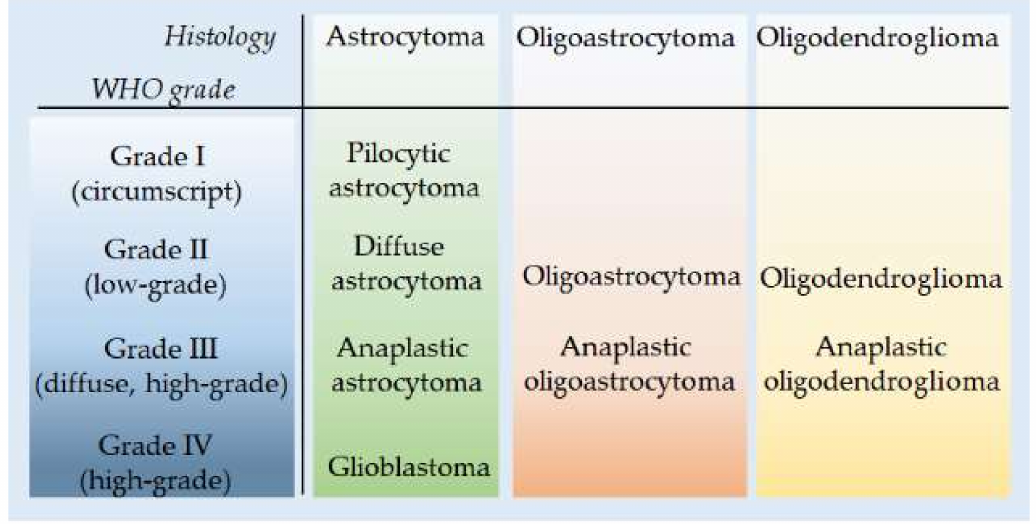
Figure 1. Histological classification of gliomas according to the World Health Organization WHO (I–IV)